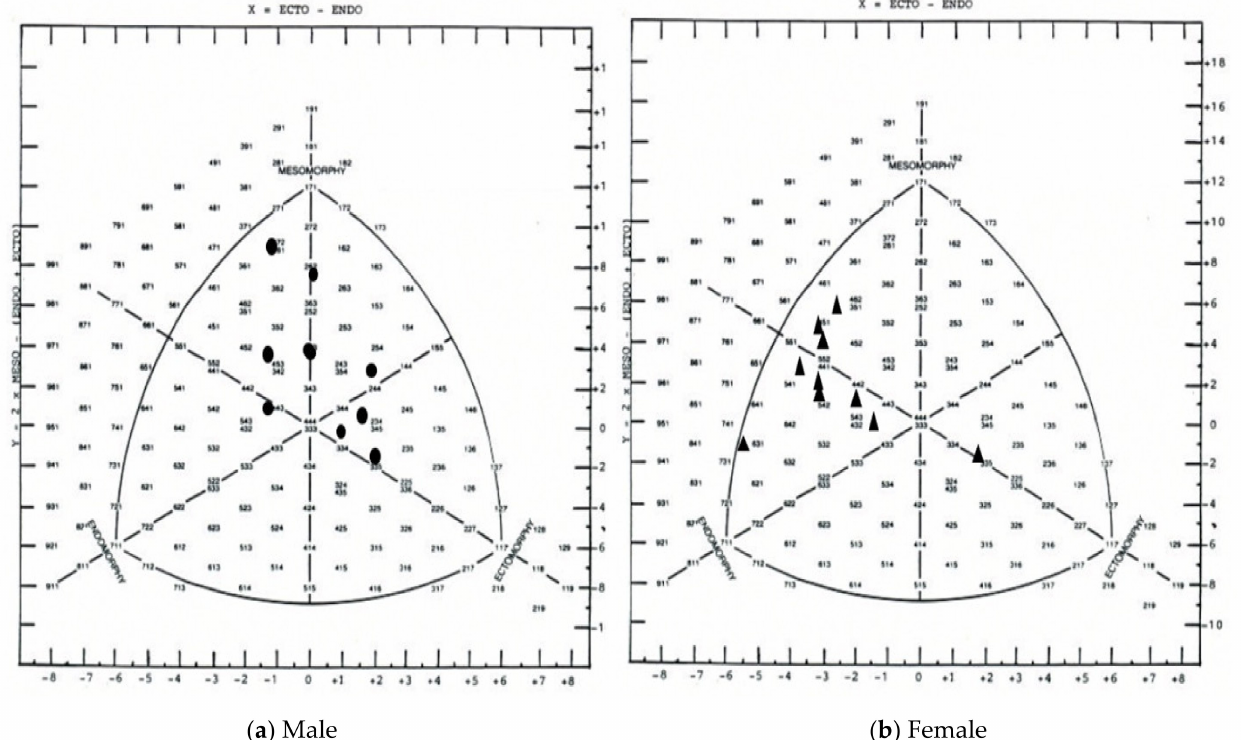
Figure 1. Somatochart of male and female water